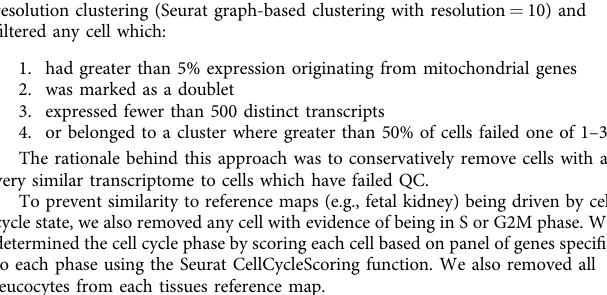
Fig. 5 Malignant rhabdoid tumors. A Bulk MRTs compared to fetal kidney: The relative contribution of single cell derived signals from fetal kidney in explaining the bulk transcriptomes of 65 malignant rhabdoid tumors (MRTs) along with control populations. The relative contribution of each signal to each bulk RNA-seq sample is shown by the y-axis. Each signal/sample combination is represented by a single point and boxplots shows the distribution with median (middle line), 1 st and 3 rd quartiles (box limits) and 1.5 times the inter-quartile range (whiskers). Each signal type is abbreviated and colored as per the legend, with squares for fetal and circles for mature. MRT samples are shown on the left and control samples on the right, where “ Leukocytes ” are bulk transcriptomes from fl ow sorted leukocytes and “ Leukemia ” represent B-precursor acute lymphoblastic leukemia. B UMAP of single cell MRT transcriptomes: Each dot represents a single transcriptome from either tumor/tubular derived organoid cells (white), fresh tissue MRTs cells (gray) or archival MRT nuclei (black). Contours indicate tumor cells, stroma, and leucocytes as labeled. C Log similarity of single cell MRT cells to fetal kidney and developing mouse: Comparison of the transcriptomes in B to cellular signals de fi ned from single cell reference transcriptomes. The reference population is indicated on the x-axis and the gray bar on the left indicates the technology each cell was derived from. Each row corresponds to a single transcriptome from B . The color scheme encodes the logit similarity score for each cell against each reference population (see Methods). D Immunohistochemistry of TWIST1 in MRT and normal kidney: Staining of a region of normal kidney and MRT tissue for TWIST1 . The MRT image shows a part of the tissue selected for being TWIST1 positive, there were large sections of tumor tissue that were also TWIST1 negative. All normal kidney tissue was TWIST1 negative. This experiment was repeated 3 times and the scale bar (bottom-right) indicates 0.1 mm. Source data are available as a Source Data fi